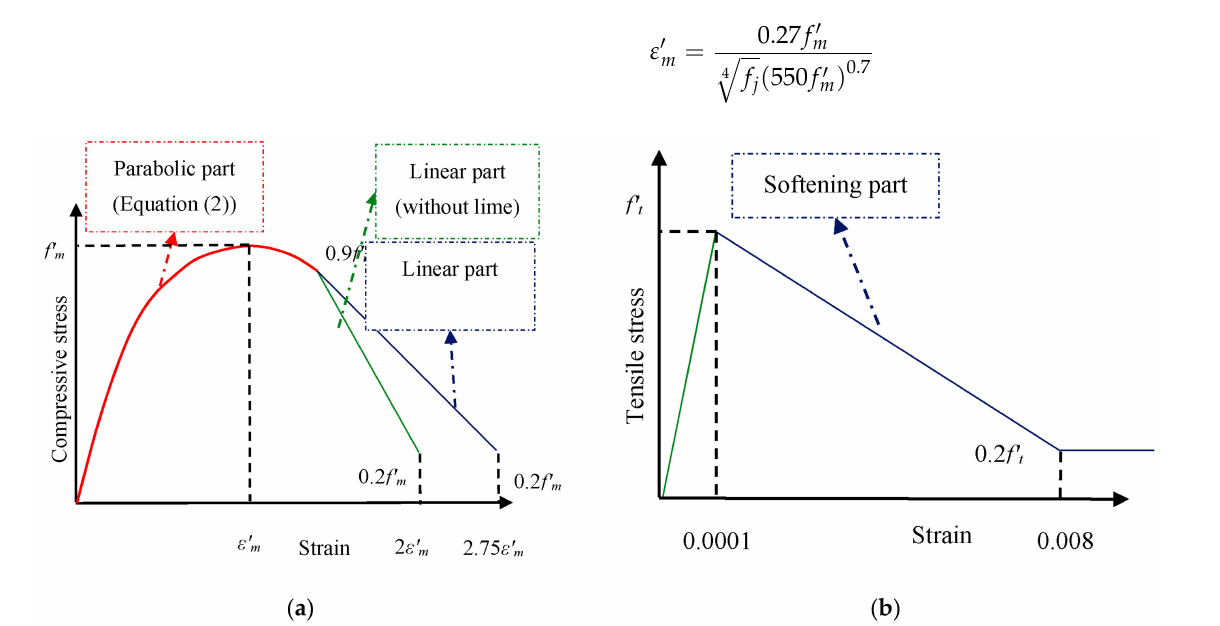
Figure 7. Constitutive law of homogenized masonry ( a ) in compression and ( b ) in